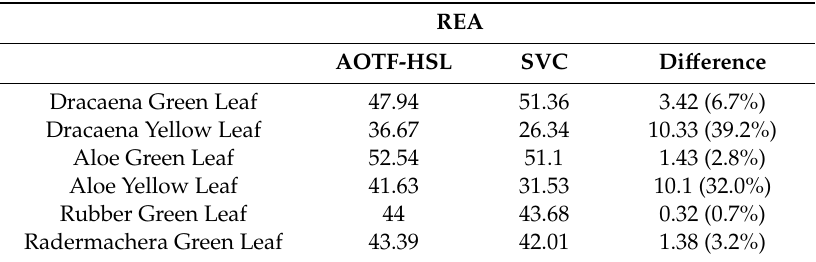
Table 4. “Red edge” area measuring results.